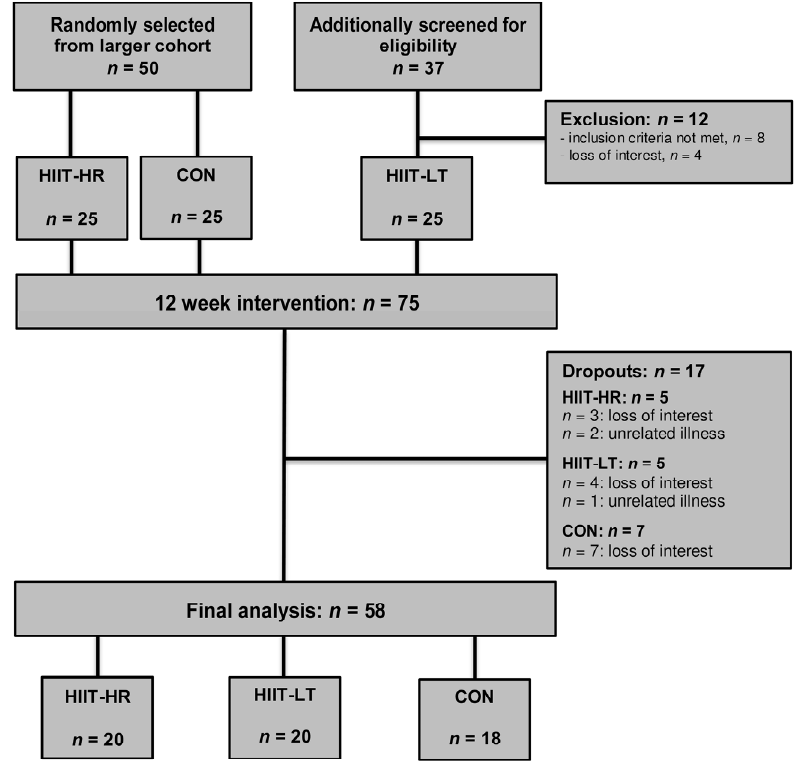
Figure 1. Study flow chart.